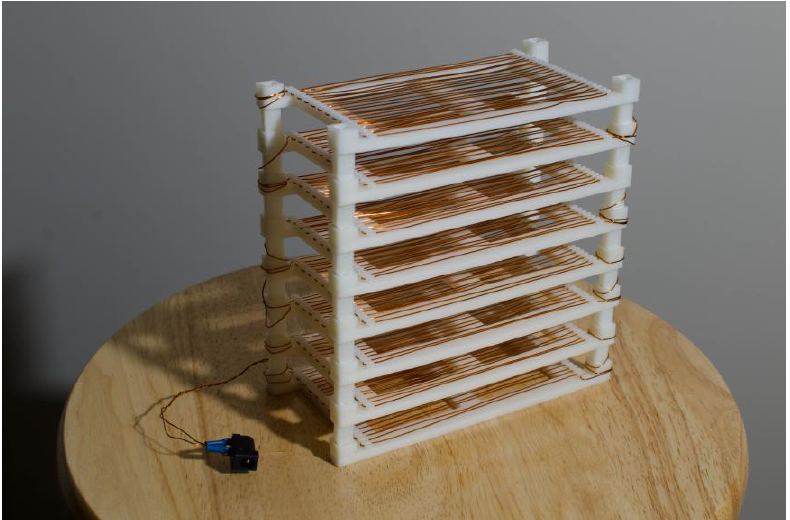
Figure 3. The completed 30-slide open-source dryer.